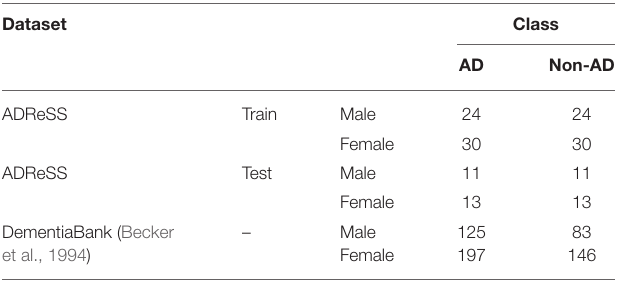
TABLE 2 | ADReSS Training set from Luz et al. (2020): basic characteristics of the patients in each group (M, male; F, female). AD Non-AD